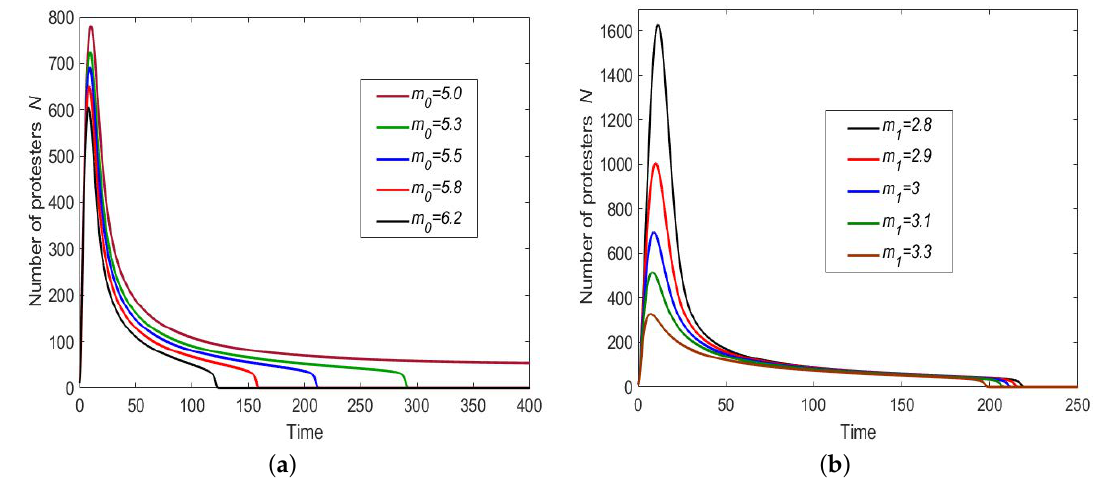
Figure 2. Solution of Equations (1) with (2) and (5) obtained for different parameter values of m 0 and m 1 . ( a ) m 1 = 3, the values of m 0 are given in the figure legend. ( b ) m 0 = 5.5, the values of m 1 are given in the figure legend. Other parameters are (cid:101) 0 = 0.1, (cid:101) = 3, a = 150, h = 35, and b = 0.01, which corresponds to m ∗ = 3.22 and m ∗ =